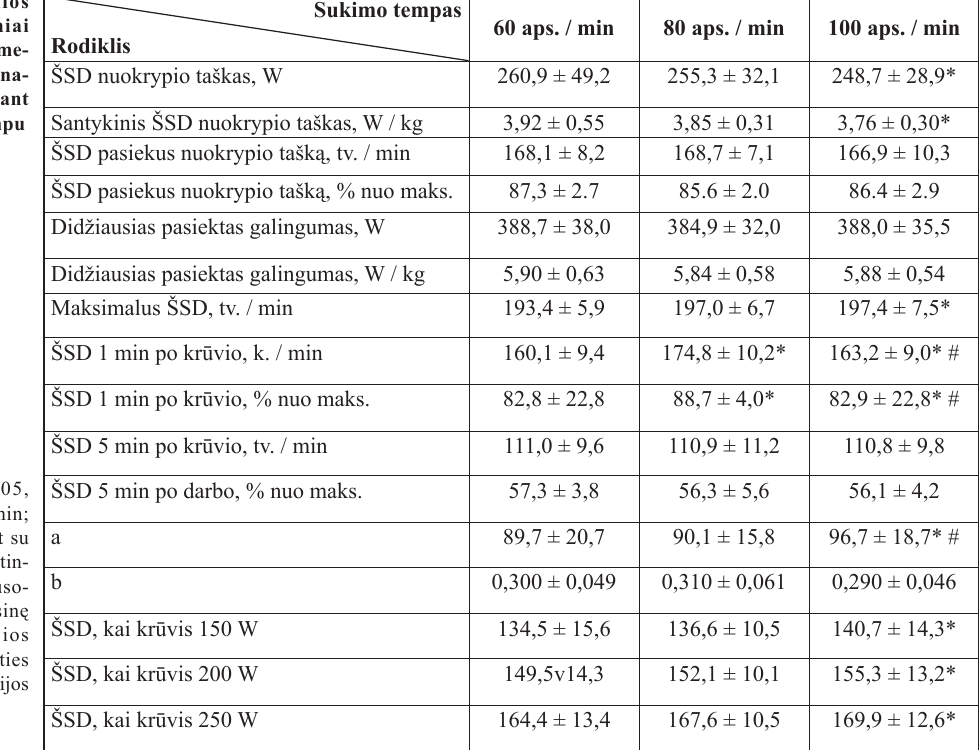
dal į aproksimuojan č ios tiesin ė s regresijos lygties laisvasis narys ir regresijos koe fi